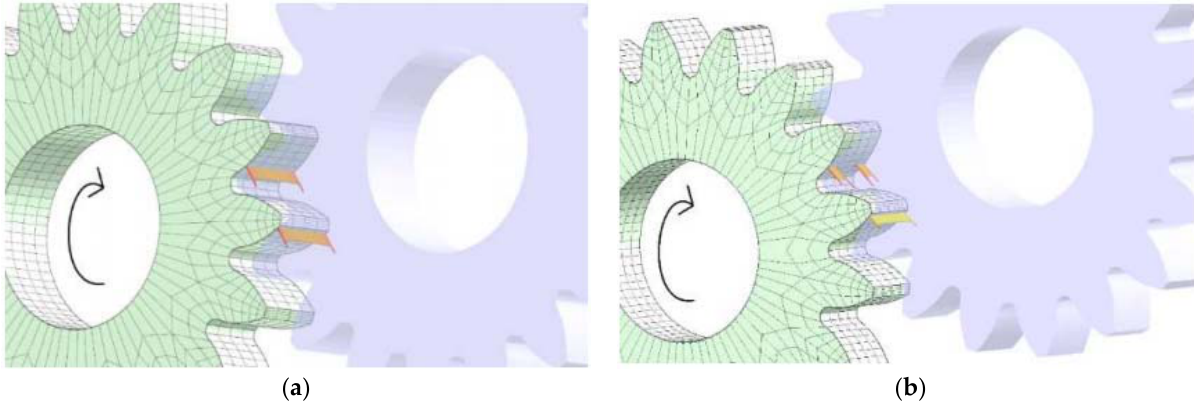
Figure 8. Pressure profile on the meshing gears of the testing gearbox: ( a ) nonpitted spur gears; ( b ) pitted (PitF) spur gears.